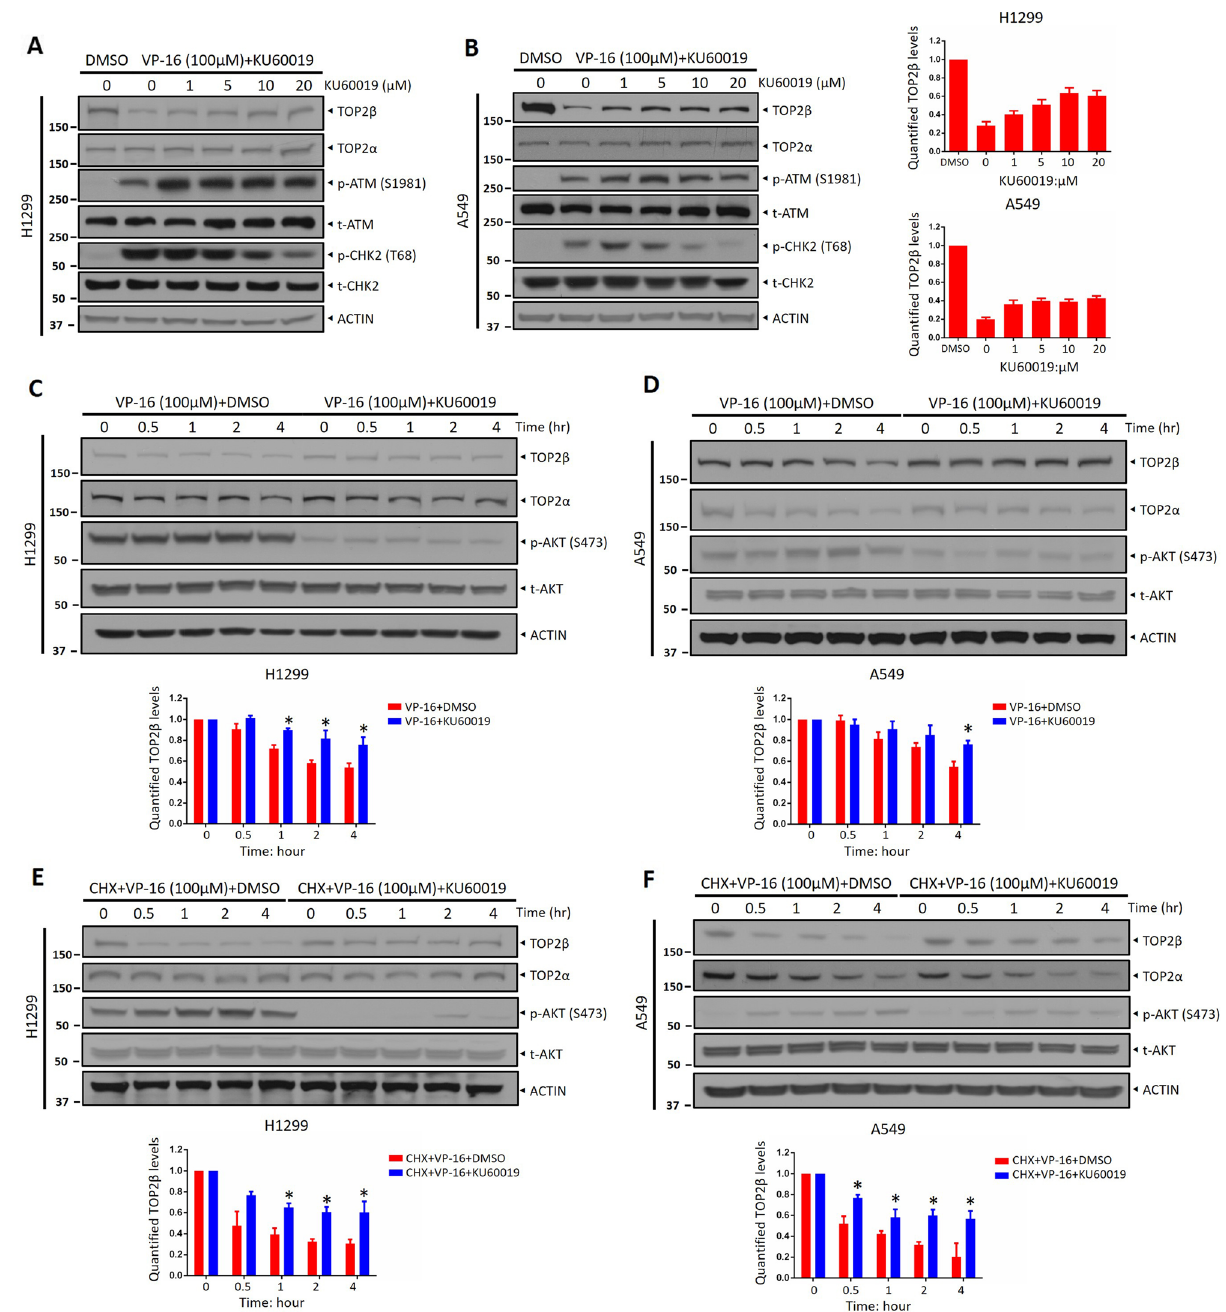
Figure 2. KU60019, an ATM inhibitor causes a dose and time-dependent accumulation of TOP2β. ( A , B ) H1299 and A549 cells were treated for 2 h with vehicle or VP-16 (100 μM) and varying doses of KU60019 (0, 1, 5, 10, and 20 μM) and then IB with the relevant antibodies. ( C , D ) H1299 and A549 cells were pretreated with DMSO or KU60019 (5 μM) for 1 h, followed by treatment with VP-16 for various time periods, and then, IB was undertaken with the indicated Abs. ( E , F ) H1299 and A549 cells following treatment with CHX and VP-16 or with CHX, VP-16, and KU60019 (5 μM) for the respective times, cells were collected and IB with the relevant antibodies. All experiments were independently repeated three times. Densitometry quantification was performed with Image J, and the decay curves are shown. According to the molecular weight, the nitrocellulose membrane was cut prior to hybridization with antibodies and the original blots are presented in Supplementary Fig. 2. Molecular weight markers are noted to the left of blot